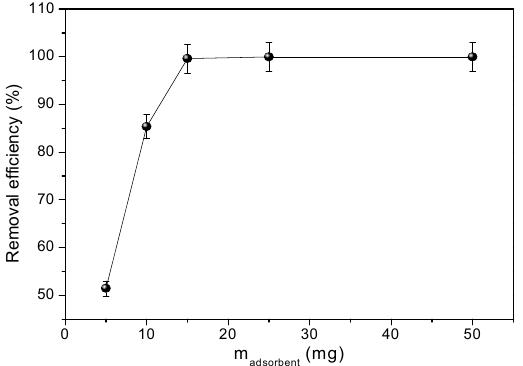
Figure 8. Adsorbent mass dependence of the removal efficiency C 0 = 70 mg L −1 .